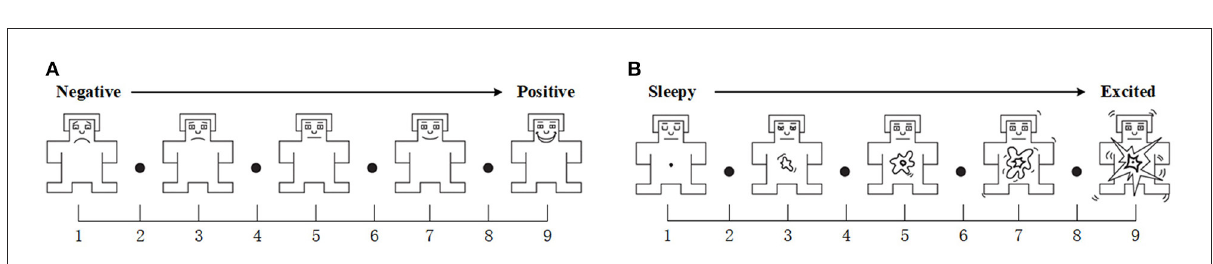
FIGURE3 V-A scale. (A) Valence, It goes from very negative feelings to very positive. (B) Arousal, It goes from sleepy to excited.